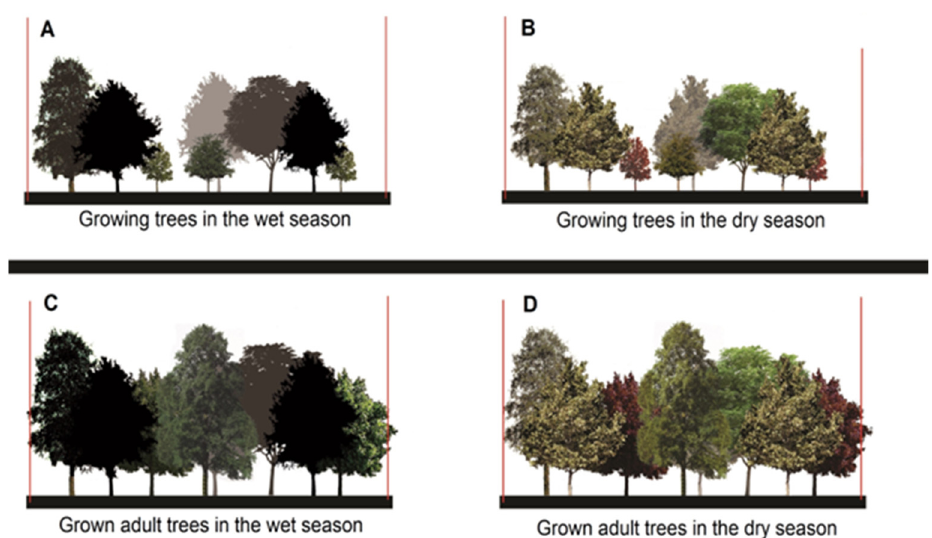
Figure 3. Final outlook of a proposed urban park design of a tree community module showing three different internal profiles as A-A’, B-B’ and C-C’ cuts.